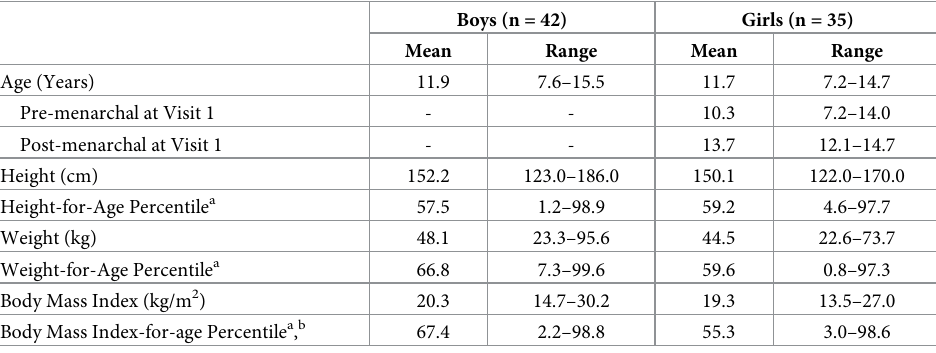
Table 1. Characteristics of study population at initial visit by